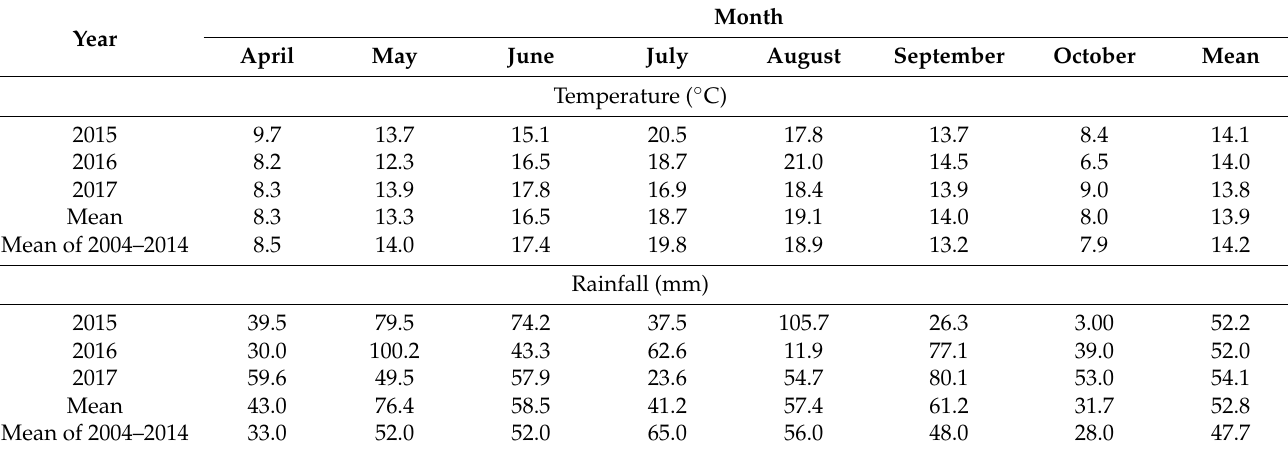
Table 1. Average monthly temperature ( ◦ C) and rainfall